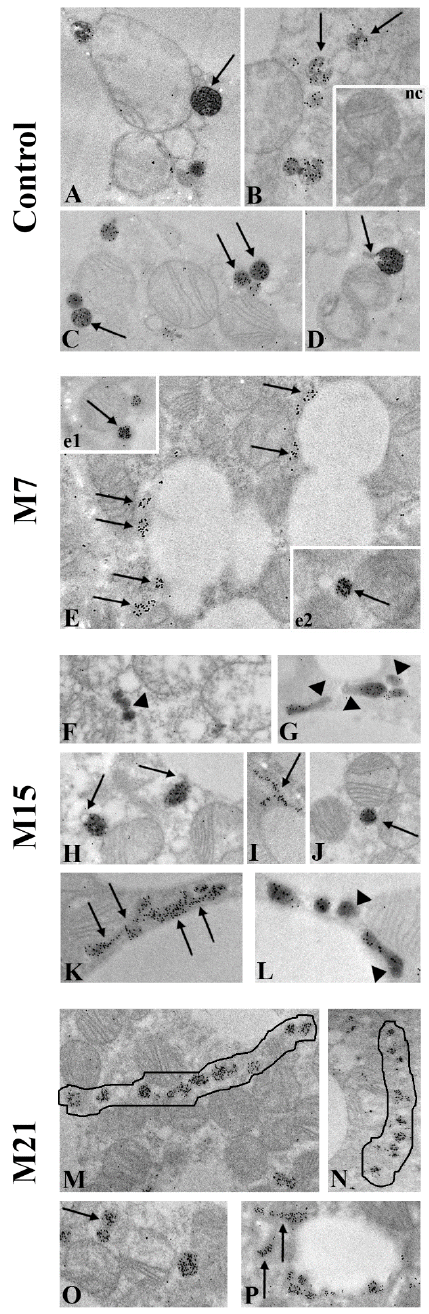
Figure 8. Maturation level of newly born peroxisomes in rat brown adipocytes in euthyroid control ( A – D ) and hypothyroid groups treated with methimazole for 7 (M7; E ,e1,e2), 15 (M15; F – L ), and 21 (M21; M – P ) days, respectively. The strongest immunopositivity for CAT was found in globular, single, fully mature peroxisomes ( A , C , J ,e1,e2—arrows), but also in peroxisomes, which had started the division process and has a nose ( D , H —arrows). CAT immunopositivity in peroxisomes that originated from the sER ( B , I , K , O , P —arrows) was weaker. Even lower CAT immunopositivity was noticed in peroxisomes within “pearls on strings” which originate from the pre-peroxisomal tubules on day 21 ( M , N —outlined structure). The weakest CAT immunopositivity occurred in peroxisomes close to the lipid bodies on day 7 ( E —arrows); some peroxisomes within “pearls on strings” ( F — arrowhead); and in very elongated peroxisomes, which originated from the pre-peroxisomal sER, which were CAT negative in their final narrower part ( G , L —arrowhead). Inset nc, negative control of immunolabeling. Magnification 17,000 ×